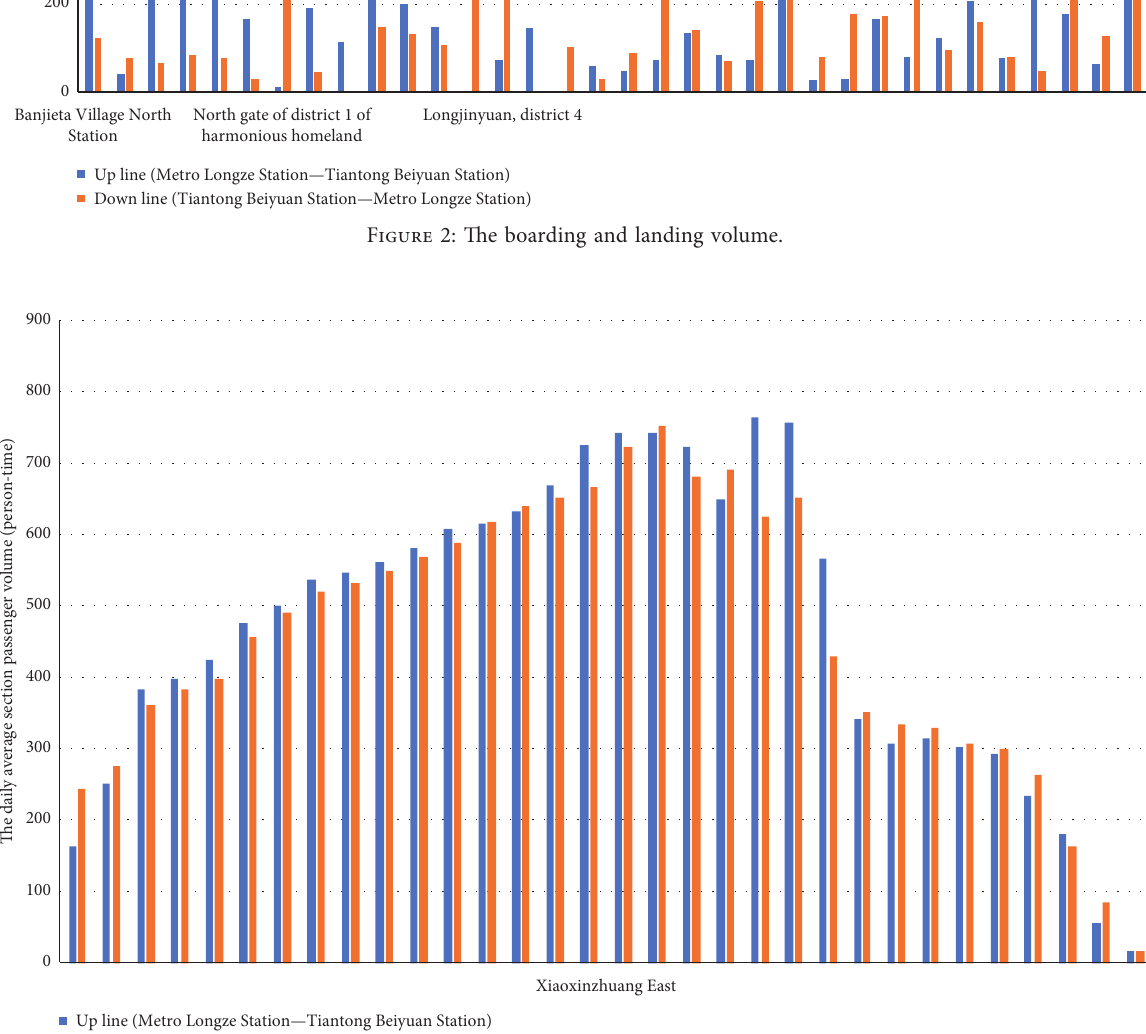
Figure 3: Daily average section passenger volume of the number 428 bus.